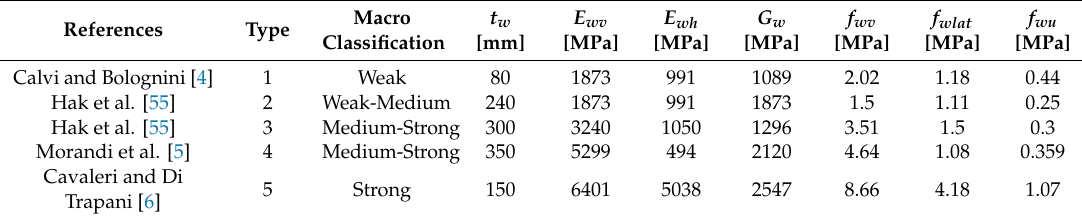
Table 3. Representative masonry